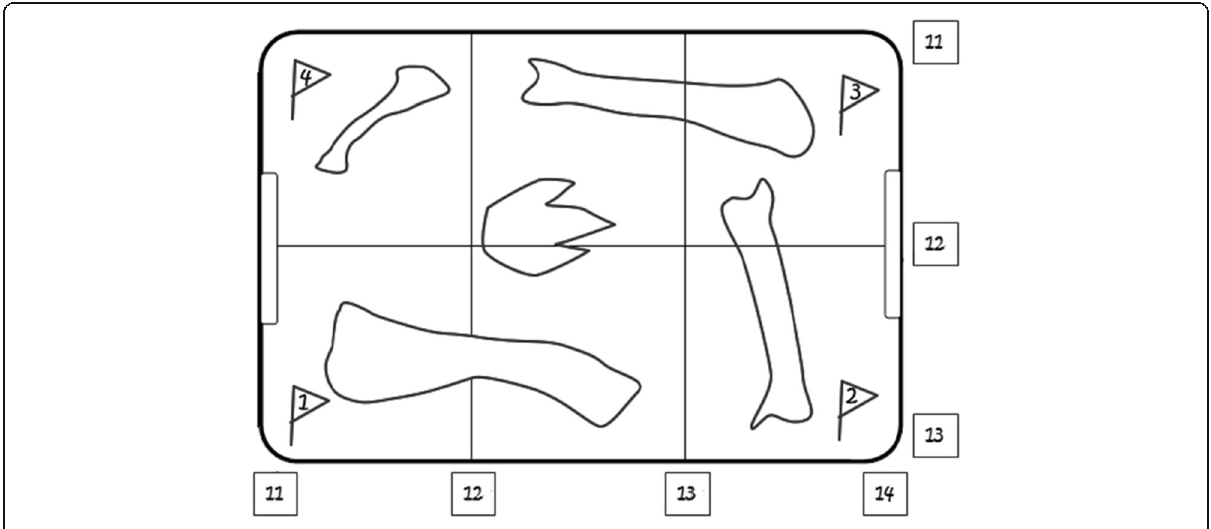
Fig. 3 A sketch-map of a map with the fossil bones revealed